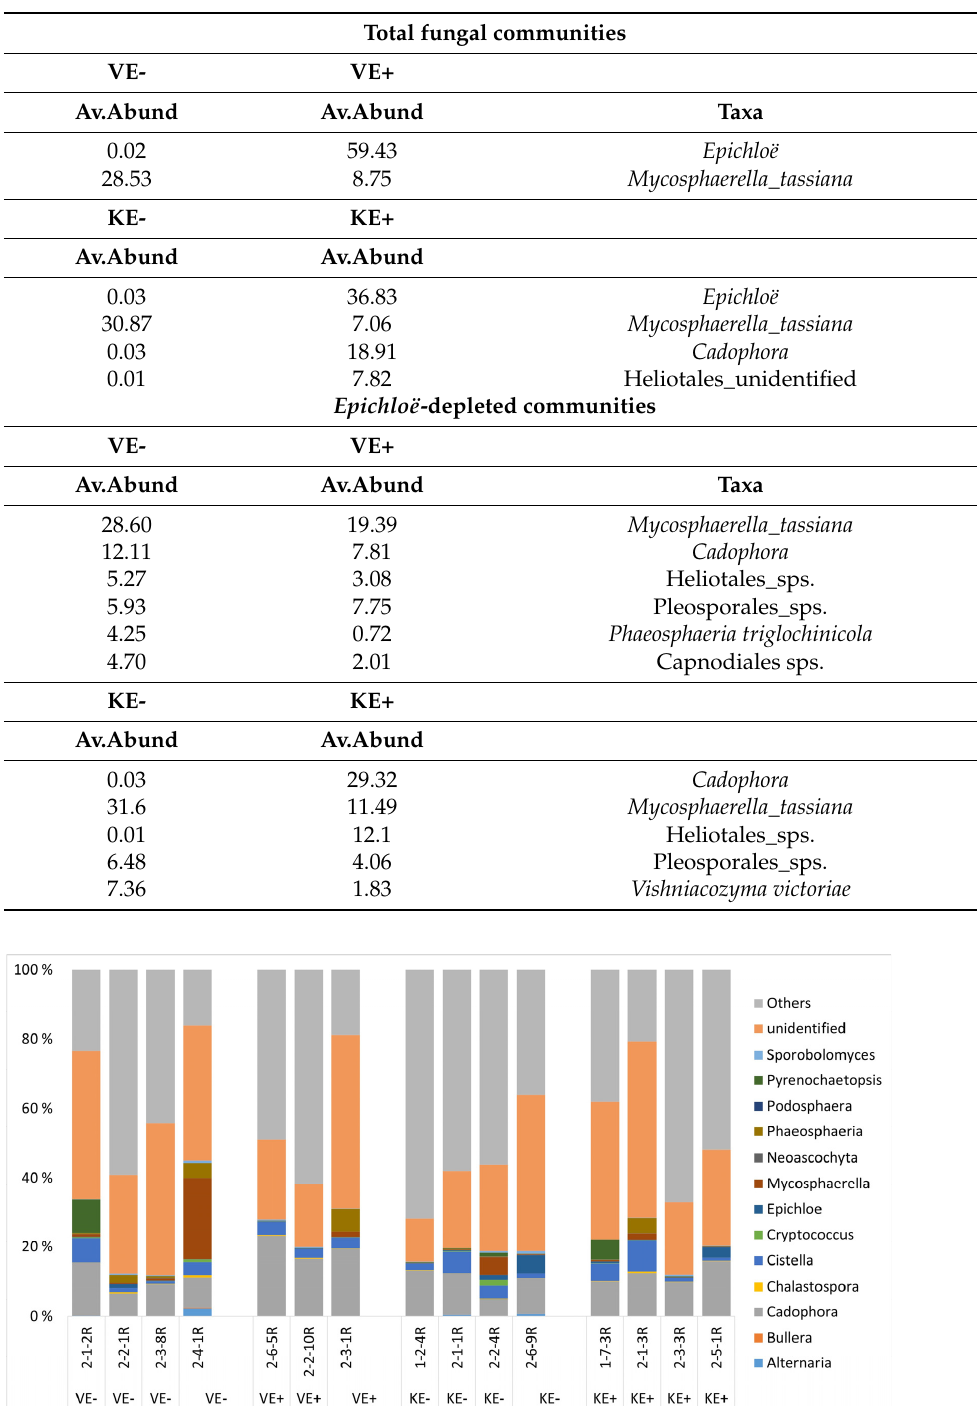
Table 3. SIMPER (similarity percentages) analysis in the leaves of E+ and E- plants in total and Epichloë - depleted fungal communities (VE-: Epichloë -free ‘Valtteri’ plants, VE+: Epichloë -symbiotic ‘Valtteri’ plants, KE-: Epichloë -free ‘Kasper’ plants, and KE+: Epichloë -symbiotic ‘Kasper’ plants) showing microbial taxa with difference in average relative abundances (Av.Abund: average abundance).